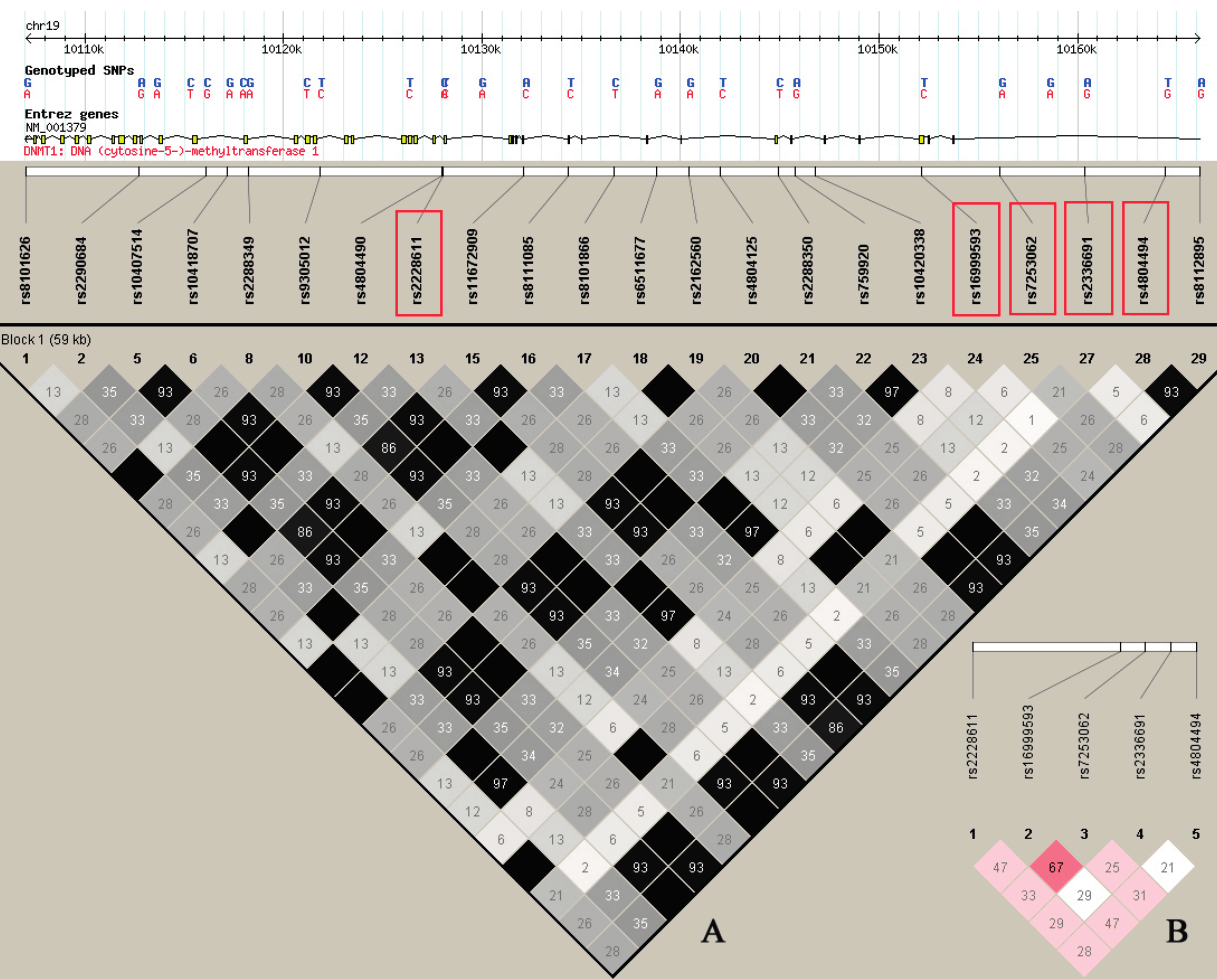
Figure 1. ( A ) Low-density (LD)-plot and haplotype blocks. Haplotype blocks generated by HaploView software (Broad Institute, Cambridge, MA, USA) based on the correlation between markers are illustrated in black. Five marker haplotype blocks highlighted in red were investigated in this research; ( B ) The schematic overview of linkage disequilibrium of the five studied SNPs (located on chromosome 19). The color scheme represents D’/LOD, while the numbers stand for R 2